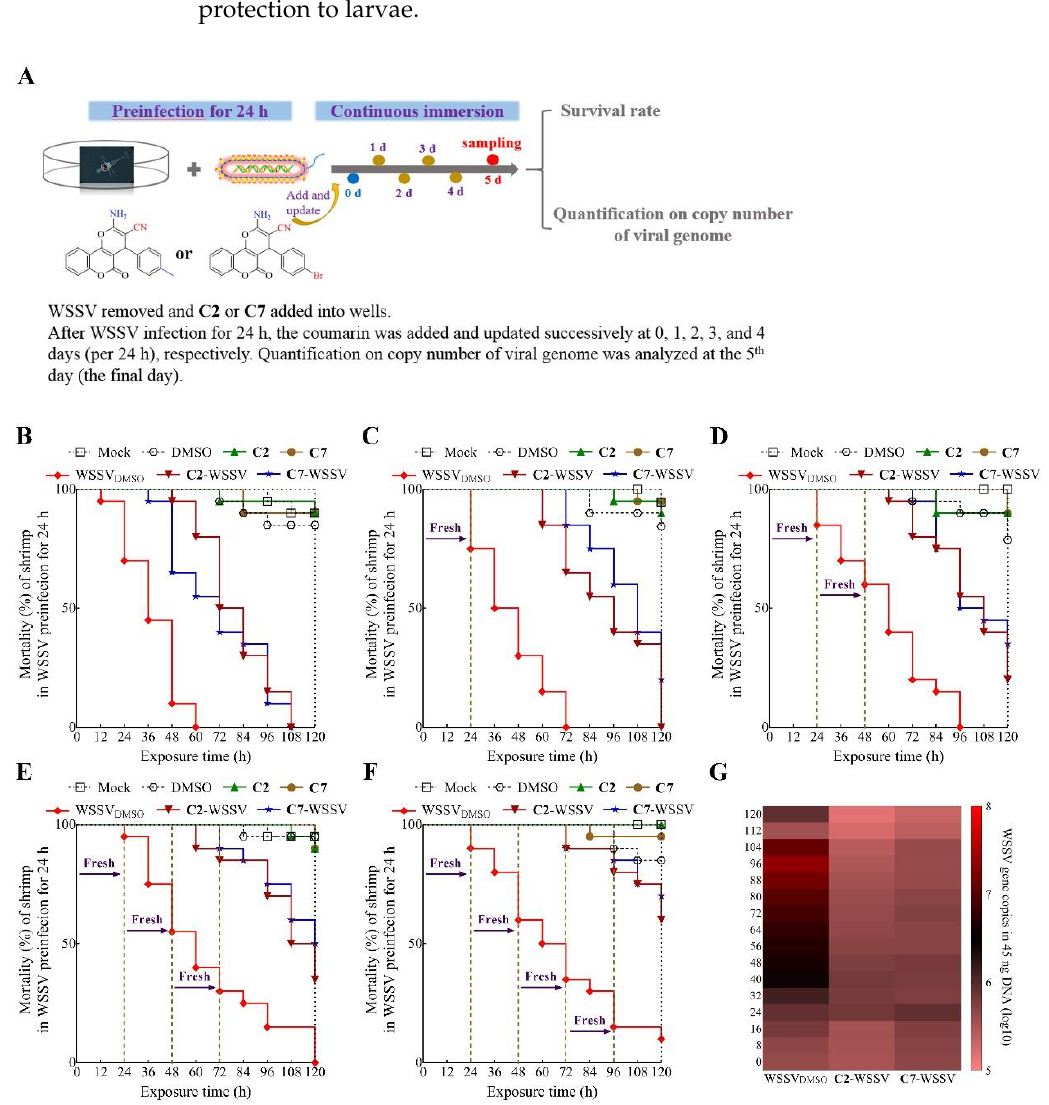
Figure 6. Continuous immersion of C2 and C7 exchange provides a strong protection on shrimp larvae against WSSV infection. ( A ) Schematic diagram describing the workflow. ( B – F ) Aquacultural water or fresh C2 and C7 medium were exchanged at 0, 1, 2, 3, and 4 days, respectively. Survivorship curves of WSSV-infected shrimp was analyzed. ( G ) The heat map indicated that quantification on copy number of viral genome was tested in every 8 h. Each value is represented as the mean ± SD normalized to values for no treatment.